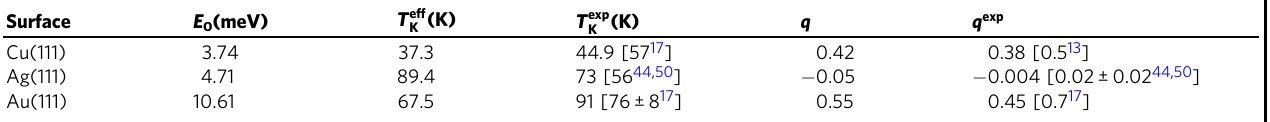
The resonance formula used for fi tting is given in Eq. (2). The effective Kondo temperature T eff K and the coupling parameter q extracted from our own fi ts of the experimental and theoretical spectra are compared to those published in refs. 13,17,44,50 (values between